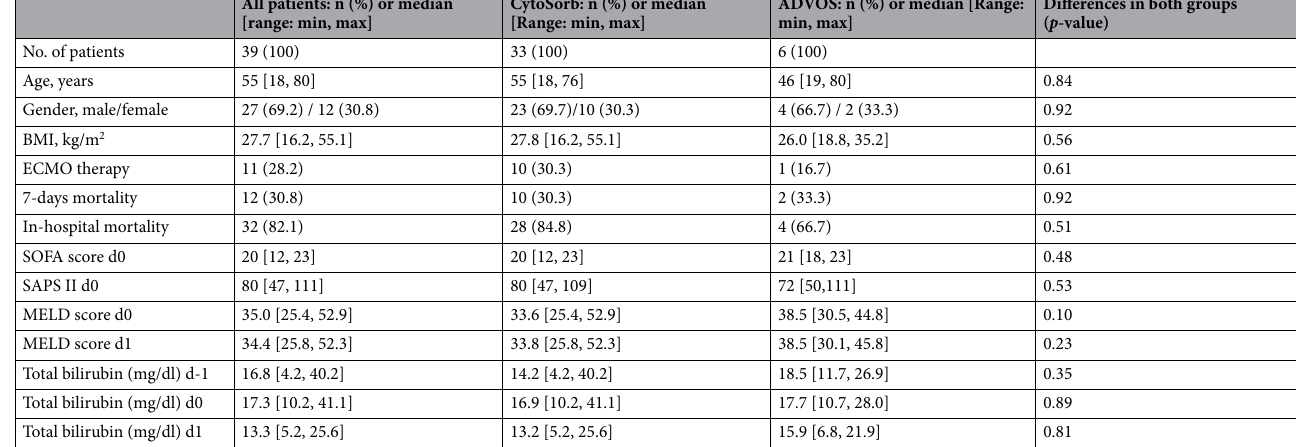
Table 1. Patient characteristics. SOFA, sequential organ failure assessment; SAPS, Simplified Acute Physiology Score; ADVOS, advanced organ support; BMI, body mass index; ECMO, extracorporeal membrane oxygenation.